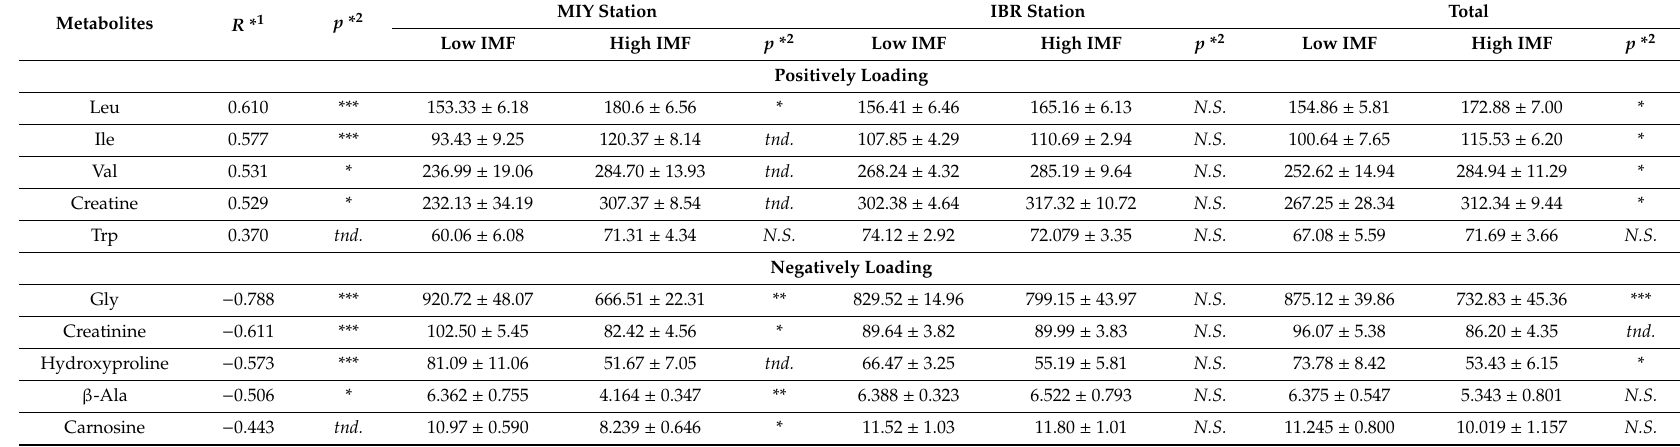
Table 3. Top 5 metabolites with positive and negative high loading values of PLS2 in the integrated analysis regarding IMF content at two stations.